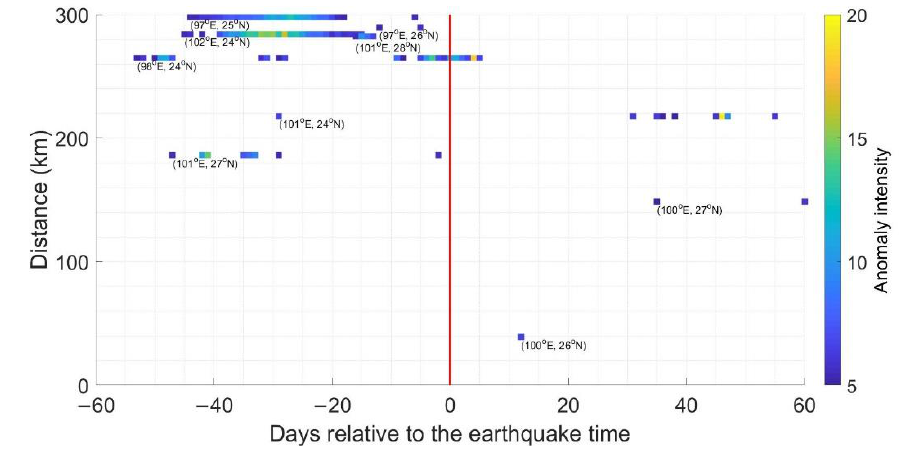
Figure 13. The anomalies around the Yunnan epicenter.